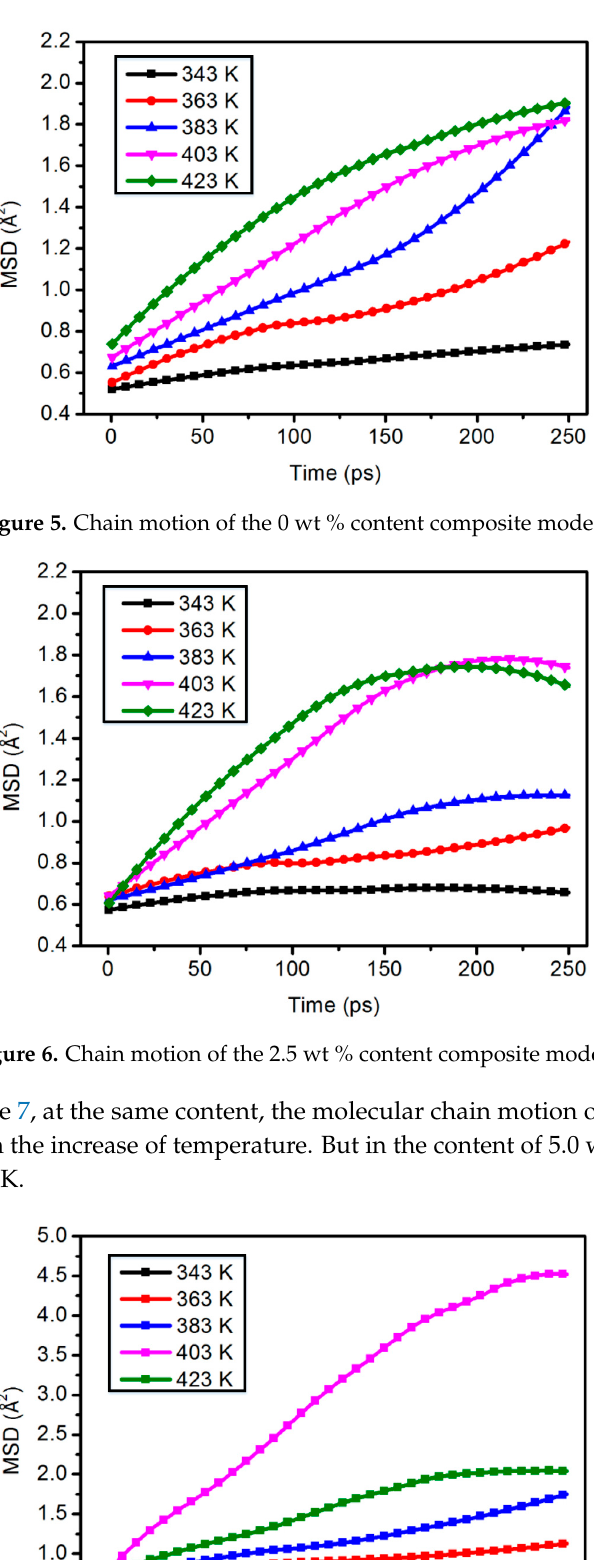
Figure 8. Chain motion of the 7.2 wt % content composite model. In Figure 9, it can be clearly seen that the MSD curves at 343 and 363, 383, and 403 K are relatively close in the composite model of 9.4 wt %.